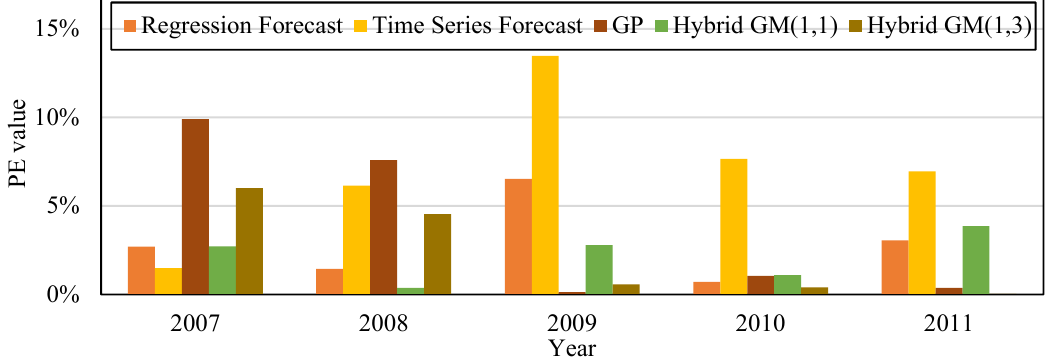
Figure 5. Comparison of PE values of the five forecast models trained with the data from 2007–2010 and tested with the data in 2011.